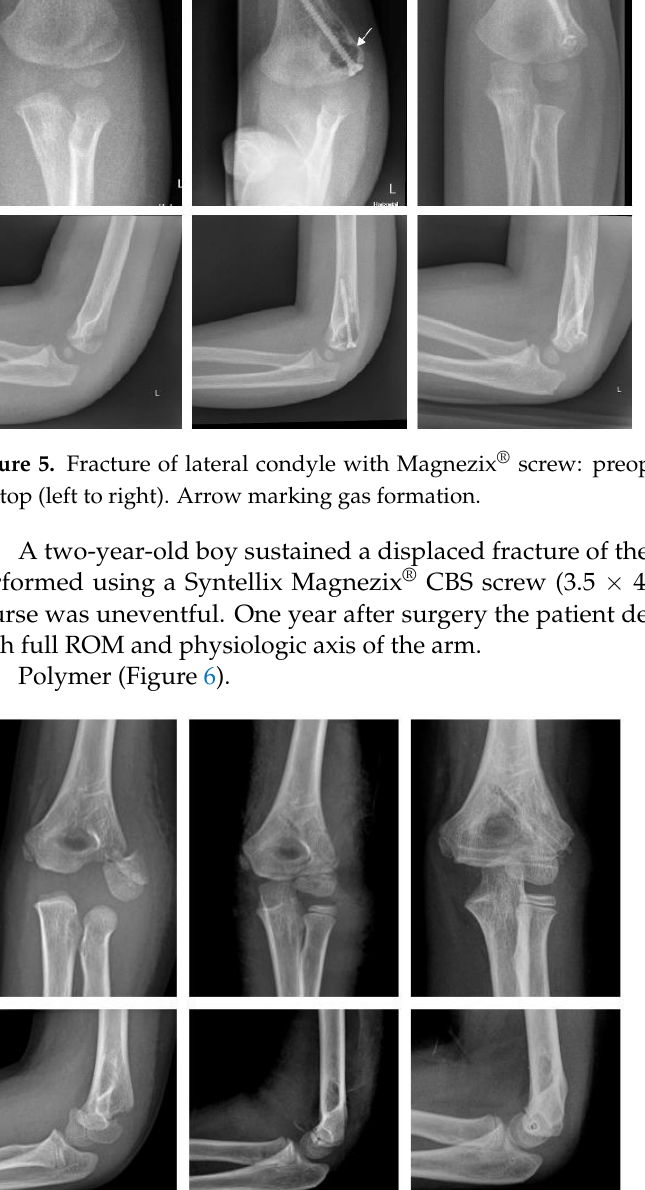
Figure 4. Fracture of medial epicondyle with ActivaPin TM : preop, 1 day postop, 6 months postop (left to right).